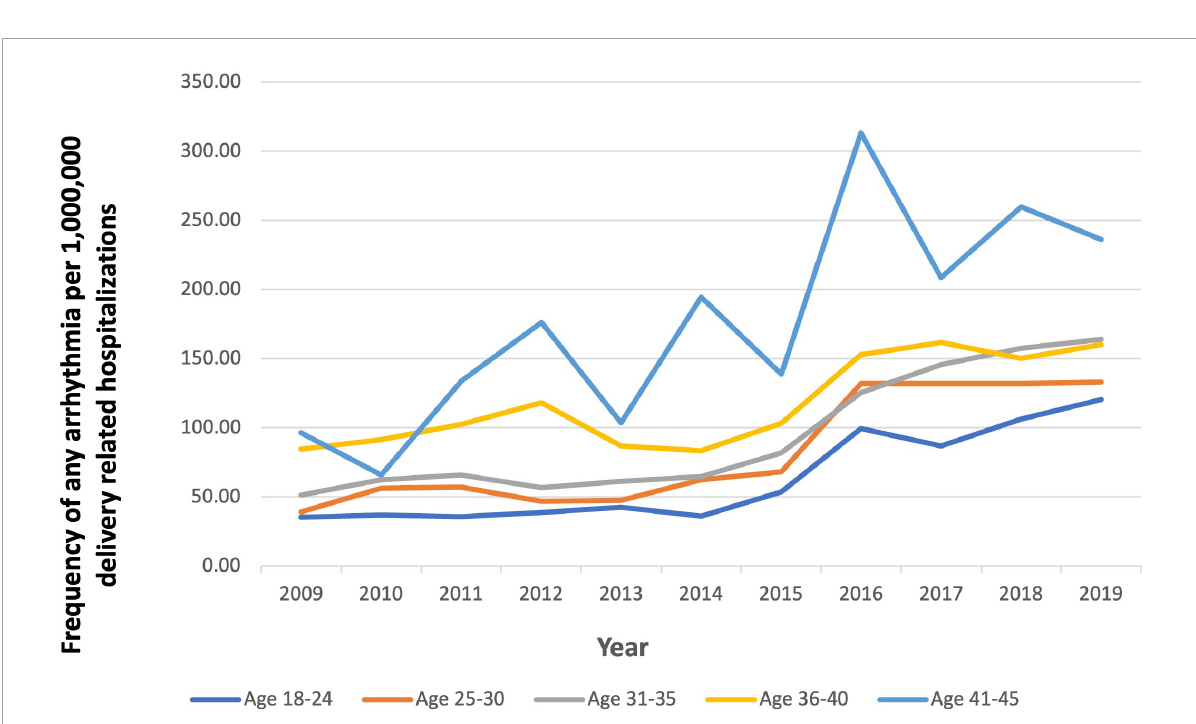
FIGURE4 Frequency of any arrhythmia per 1,000,000 delivery related hospitalizations from 2009 to 2019, stratified by